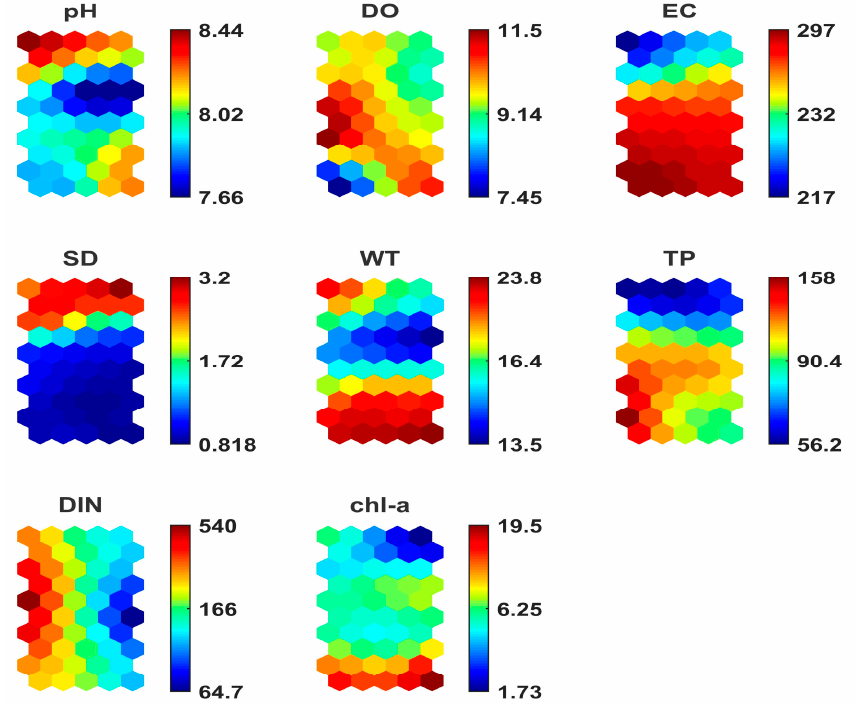
Figure 6. Visualization of the SOM’s component planes (CPs) for each environmental parameter, where the colorbars indicate the mapping of the data values.